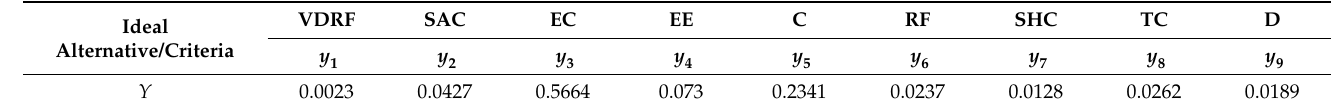
Table 9. Ideal alternatives.